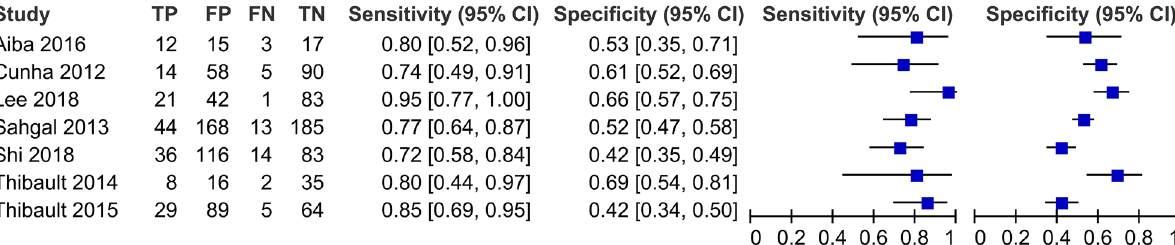
Figure 1. Coupled forest plots of diagnostic accuracy. Sensitivity and specificity of the spinal instability neoplastic score (SINS) for predicting the occurrence of vertebral compression fractures after radiotherapy in spinal metastases. This figure was drown using the Review Manager version